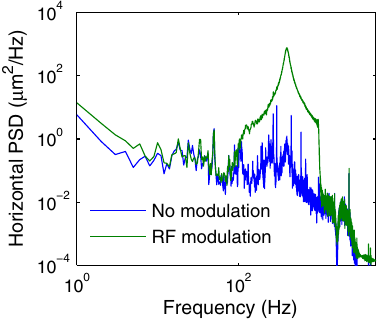
FIG. 8. Comparison of synchrotron frequency measurements made with and without rf cavity phase modulation. Beam motion was recorded at a BPM with (cid:4) x ¼ 0 : 28 m .